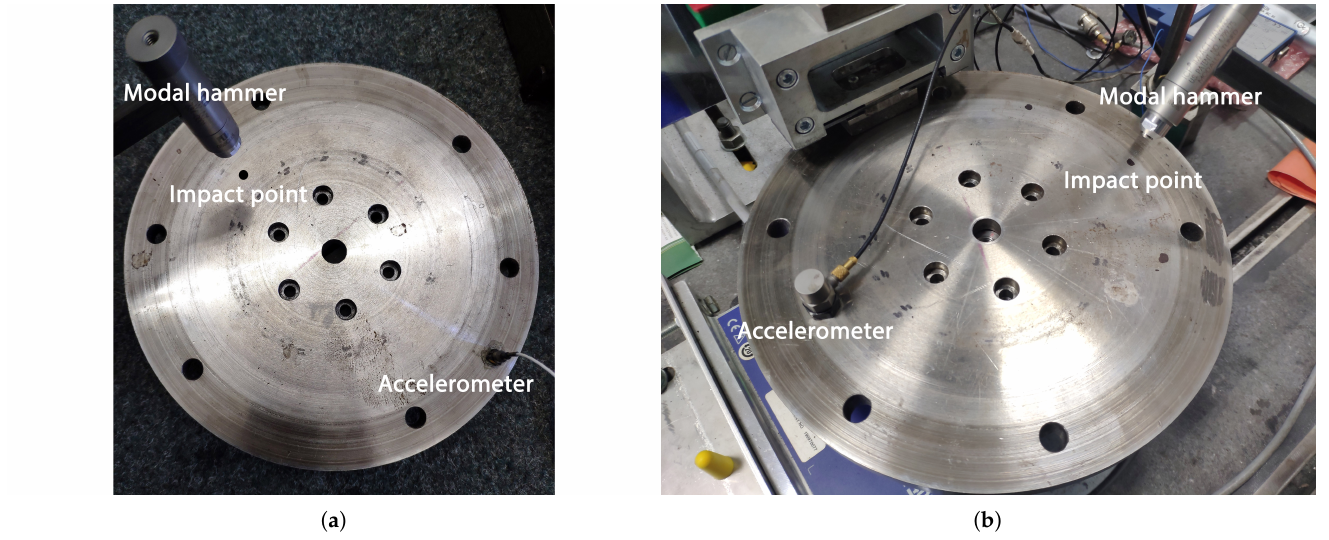
Figure 4. Schematics of frequency response function (FRF) measurement on the ( a ) free and ( b ) attached discs. Performing fast Fourier transform (FFT) on multiple measured signals, multiple